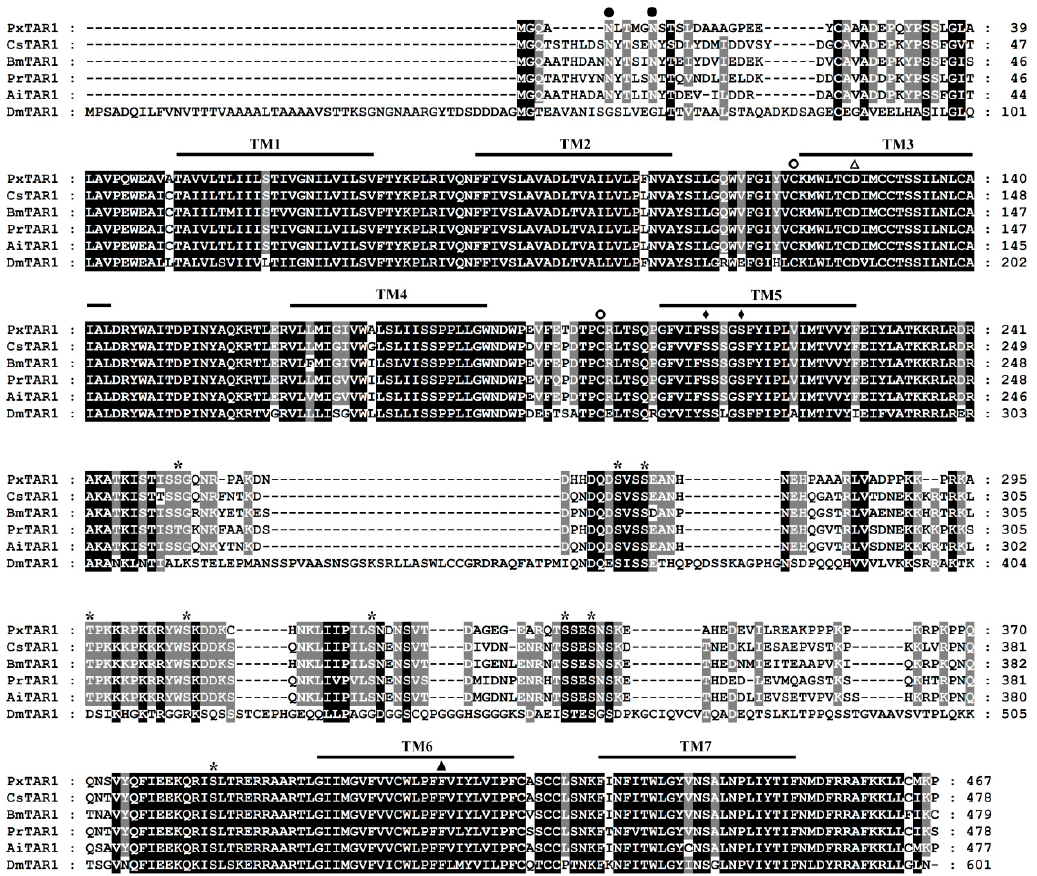
Figure 1. Multiple sequence alignment of PxTAR1 and orthologous receptors. Shaded sequences highlight the identity level of amino acids between the receptors. Amino acid position is indicated on the right and the predicted seven transmembrane regions are indicated by TM1-7. Potential N-glycosylation sites and potential phosphorylation sites for protein kinase C are labeled by filled circles and asterisks, respectively. Conserved cysteine residues in the first and second extracellular loops are labeled with empty circles. The aspartic acid residue (D127) and the serine residues (S211and S215) that were predicted to be involved in agonist binding are labeled with triangle and filled rhombus. The second phenylalanine after the FxxxWxP motif in TM6, which is a unique feature of aminergic receptor, is indicated by a filled triangle. CsTAR1 ( C. suppressalis ; GenBank accession number: AFG26689), BmTAR1 ( B. mori ; BAD11157), PrTAR1 ( Pieris rapae ; AFX62896), AiTAR1 ( A. ipsilon ; ACN12797), and DmTAR1 ( D. melanogaster ; BAB71788).